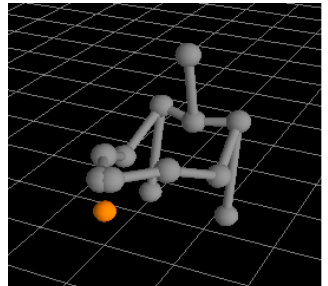
Figure 2. 3D model created in